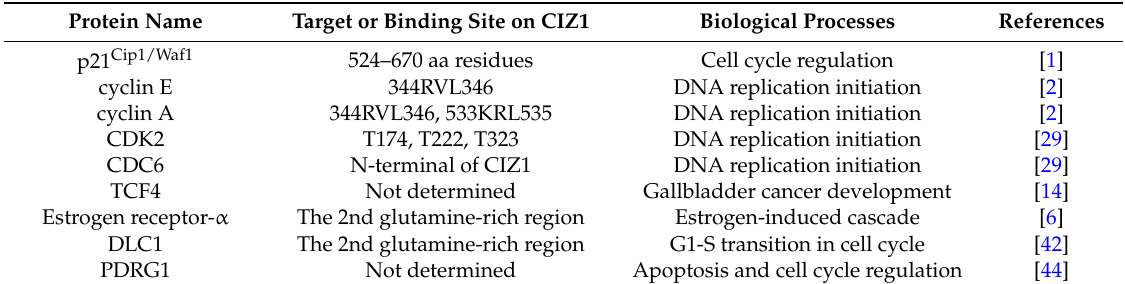
Table 3. CIZ1 interacting